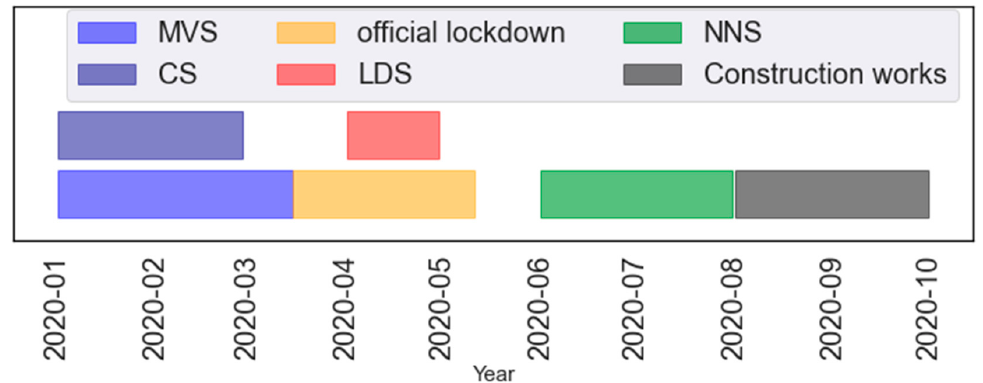
Figure 2. Datasets for 2020: model validation set-MVS (3 January–15 March); comparison set-CS (January and February); official lockdown (13 March–11 May); lockdown set- LDS (1–30 April); new normal set-NNS (1 June–31 July); construction works